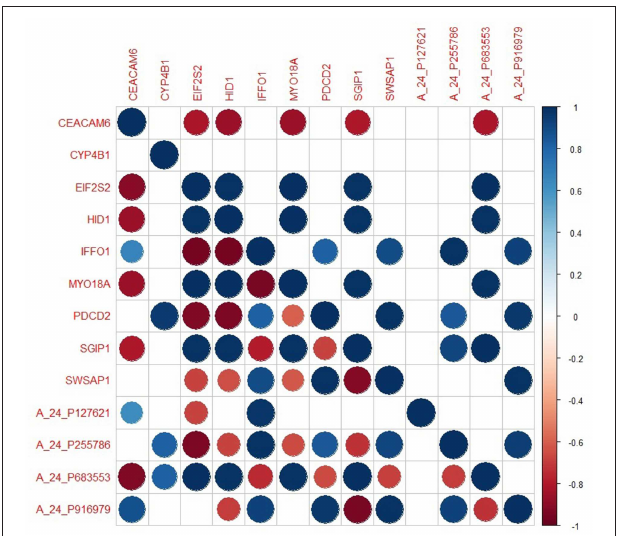
FIGURE 5 | The degree of co-expression of core module genes between invasive and non-invasive states. Upper-triangle represents invasive state whereas lower-triangle shows non-invasive state.